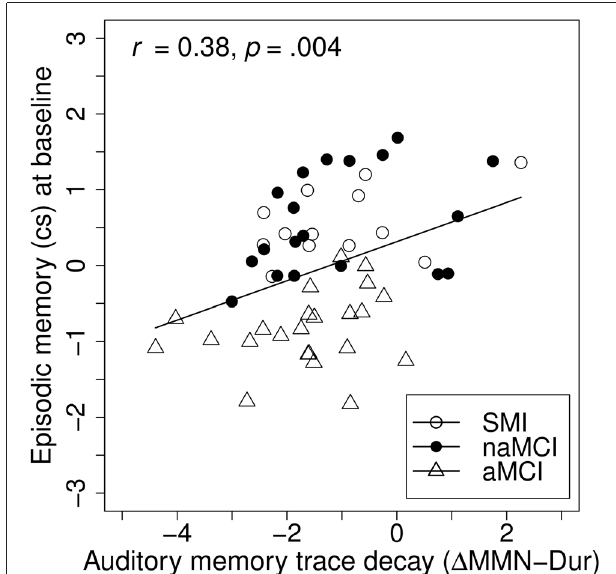
FIGURE 4 | Baseline associations between auditory memory decay and episodic memory. Auditory memory reflected by the difference score between MMN amplitude after duration deviant in the Opt1 paradigm and the MemTra paradigm ( ∆ MMN–Dur), higher scores indicating less auditory memory trace